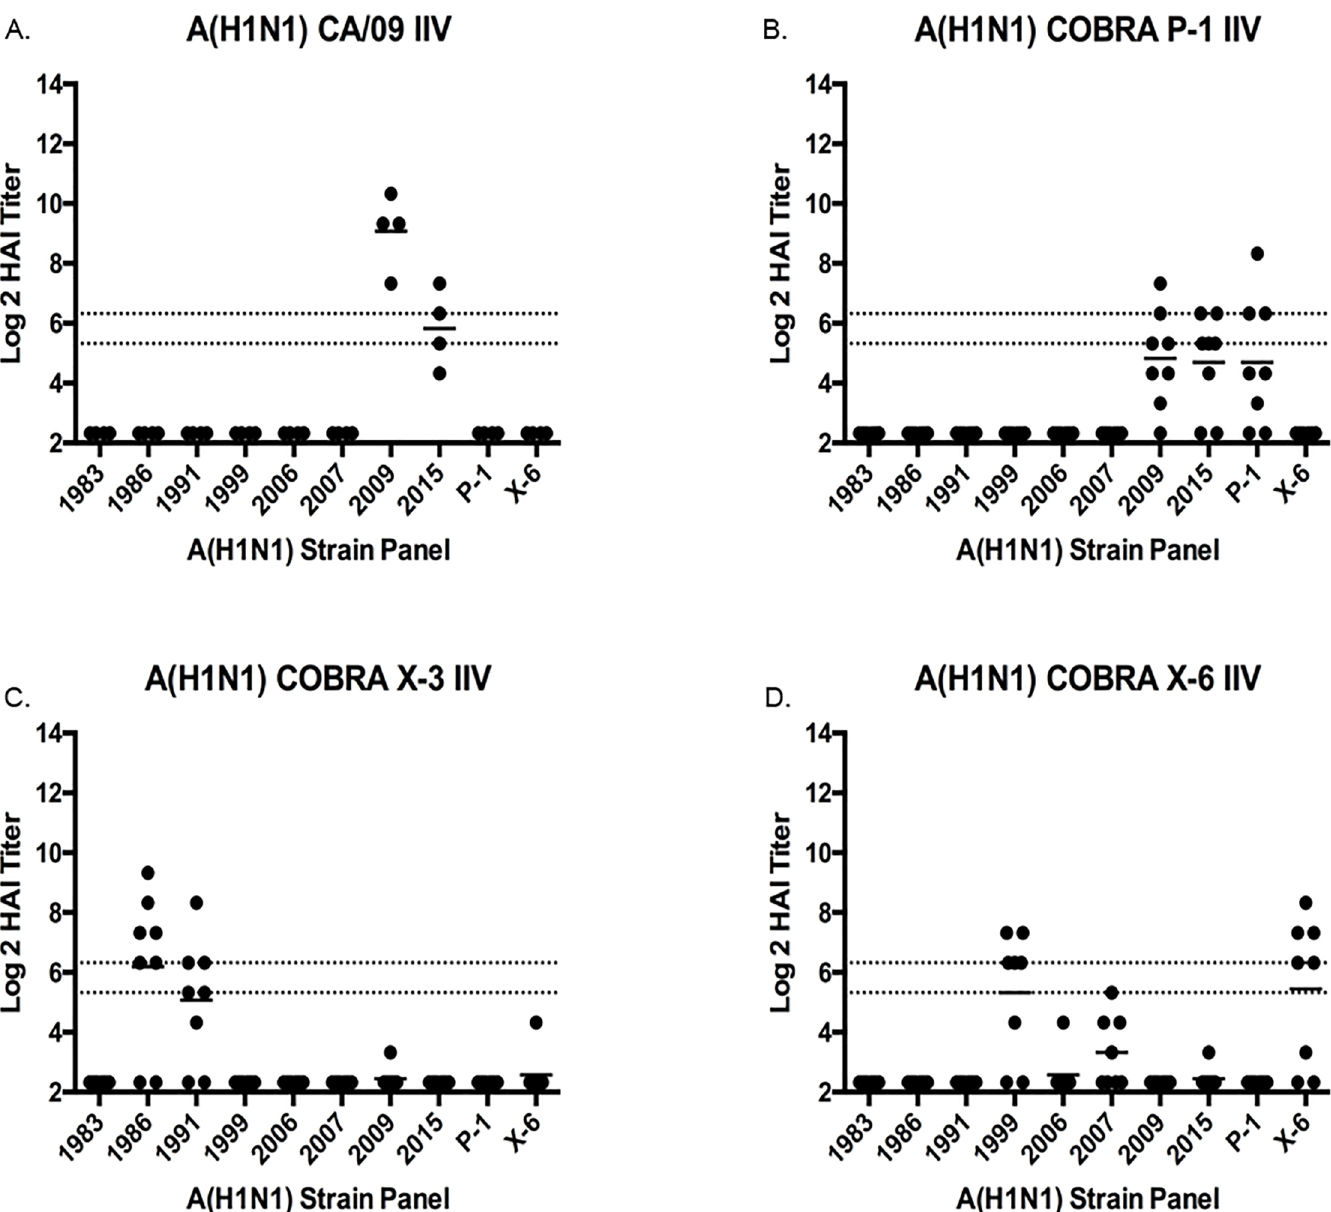
Fig 3. Hemagglutination inhibition serum antibody titers induced by vaccination of ferrets with H1N1 IIV vaccine expressing COBRA HA antigens or HA proteins from wild-type viruses. HAI titers were determined for each group of immunologically naïve ferrets (n = 8) vaccinated two times (days 0 and 28) with 1 of the 3 COBRA H1N1 IIV vaccines (P1, X3 or X6) or H1N1 IIV vaccines expressing wild-type HA proteins from CA/09 against a panel of 8 H1N1 influenza viruses. Values are the individual animal HAI titers from antisera collected on day 56. The two dotted lines indicates the 1:40–1:80 HAI titer range. (A) CA/09 IIV; (B) P1 IIV; (C) X3 IIV; (D) X6